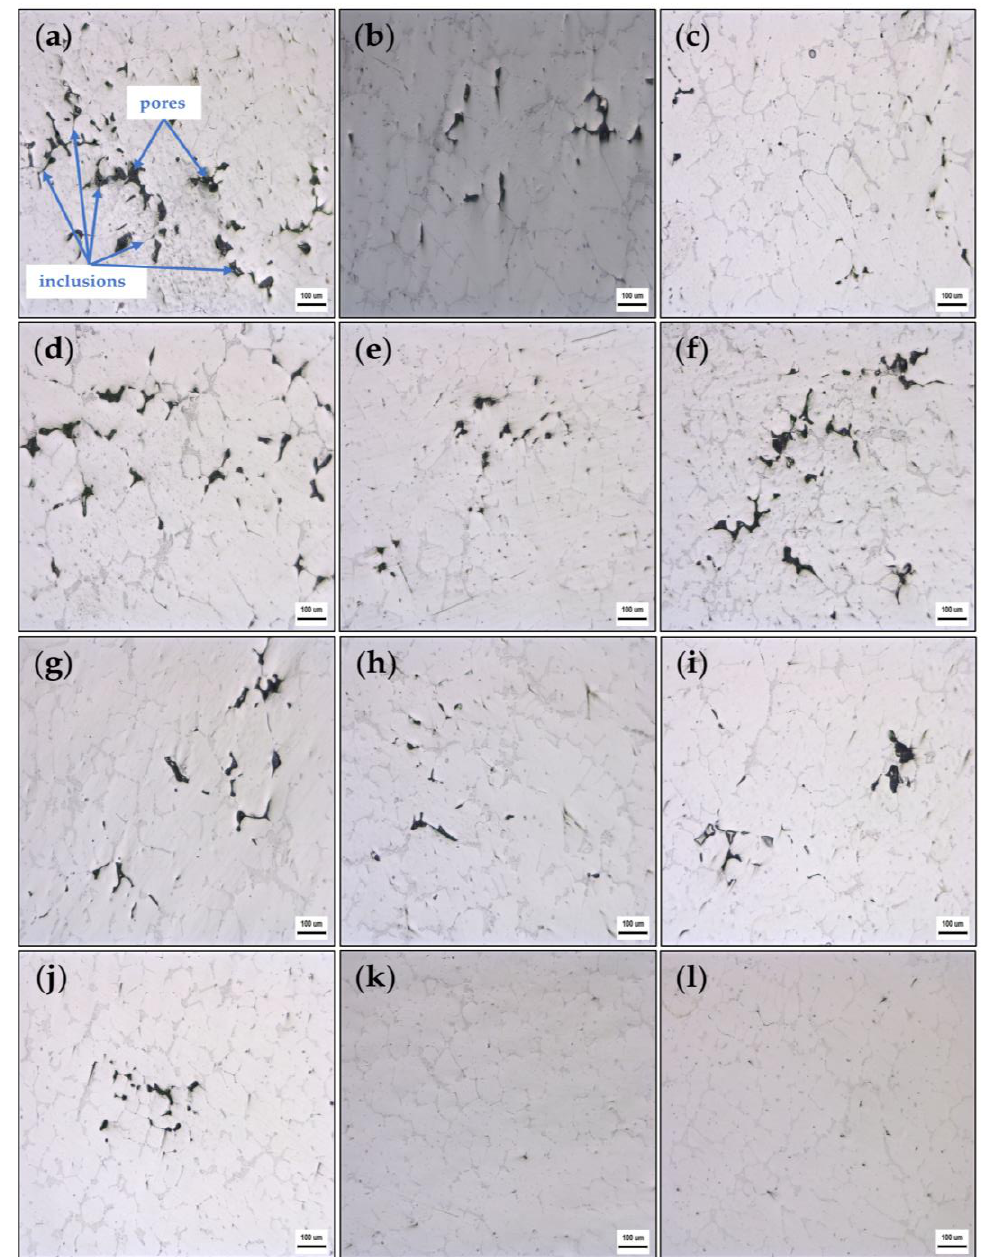
Figure 9. Microstructure of the samples: ( a ) unrefined; ( b ) refined by #1; ( c ) refined by #2; ( d ) refined by #3; ( e ) refined by #4; ( f ) refined by #5; ( g ) refined by #6; ( h ) refined by #7; ( i ) refined by #8; ( j ) refined by #9; ( k ) refined by #10; ( l ) refined by flux STJ – A3.